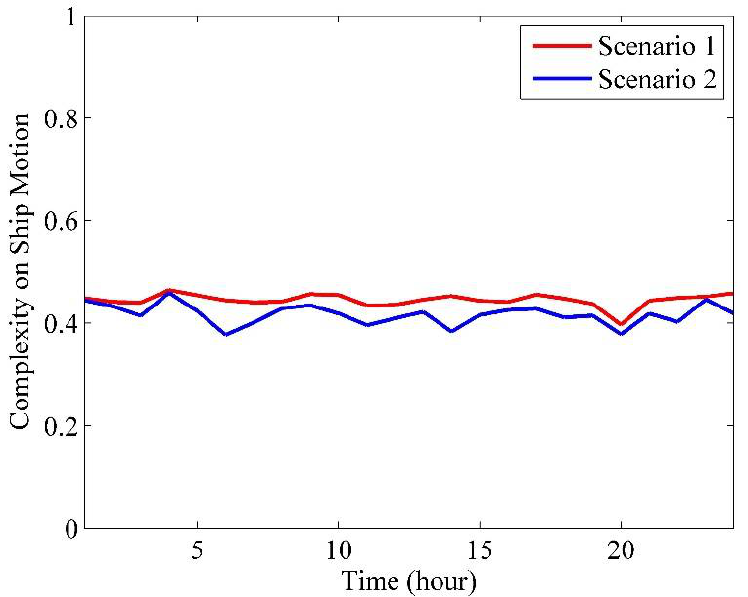
Figure 10. The location of Laotieshan PA and its main traffic flows. From Figure 10, it can be observed that there are six main traffic flows in Laotieshan PA. Two of them are extended from the direction of Laotieshan TSS. Of the rest four traffic flows, two of them are in the north–south direction, and the other two flows are close to the west–east direction. For this studied area, we divided the traffic into two situations. The first situation is that all traffic flows in PA were considered, which were exhibited as red and blue lines in Figure 10. The second situation is that only the traffic flow which nearly extends the direction of TSS was considered, which is exhibited as red lines in Figure 10. For the two situations, the complexity on ship motion was calculated based on the proposed model. The calculation was conducted for a one-time node for each hour through a day in sequence. The results are shown in Figure 11.